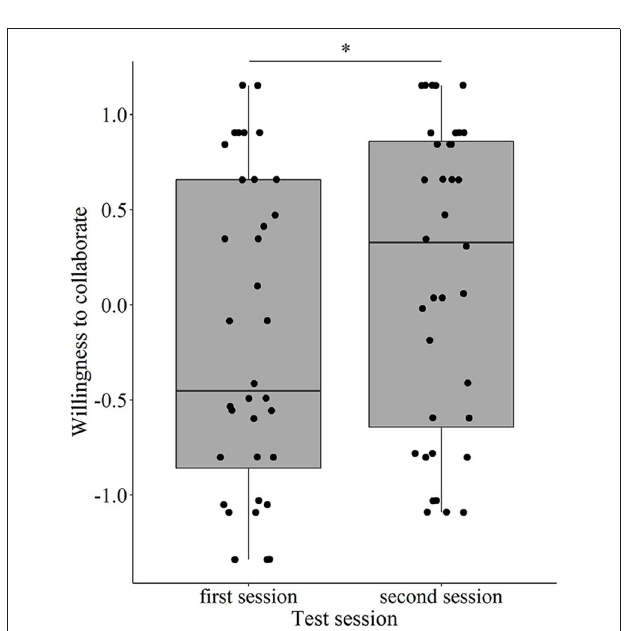
FIGURE 2 | The effect of repeated testing on the dogs’ Willingness to interact with human partners (* p < 0.001).